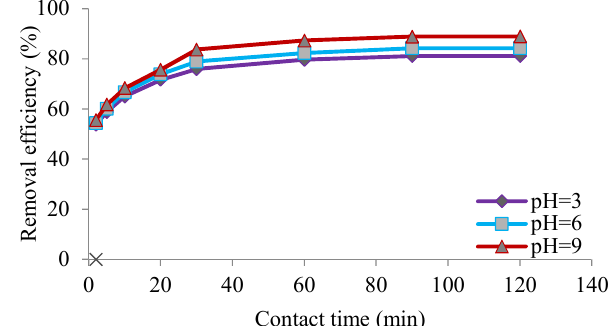
Fig. 6. Effect of pH on efficiency of ammonia nitrogen removal